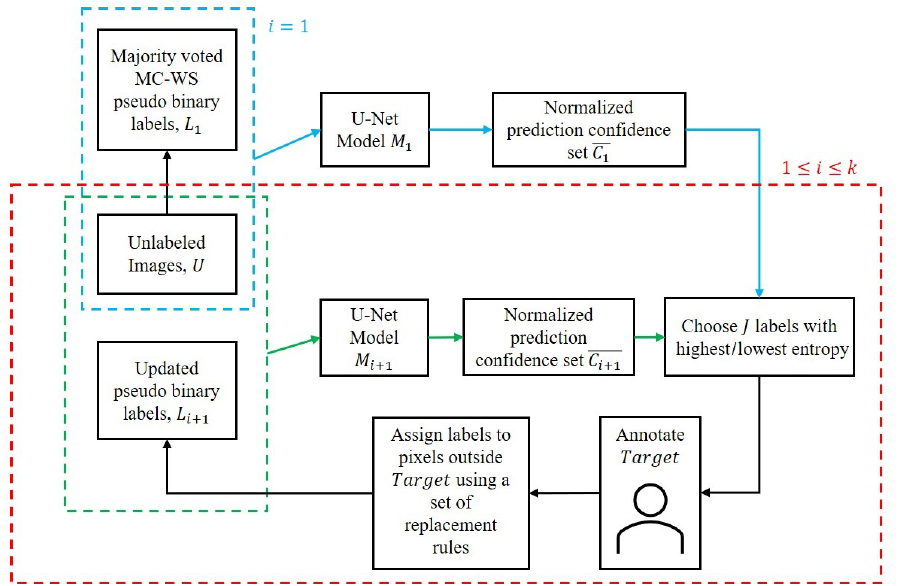
Figure 1. SSPA architecture. In this figure, k represents the termination condition described in Algorithm